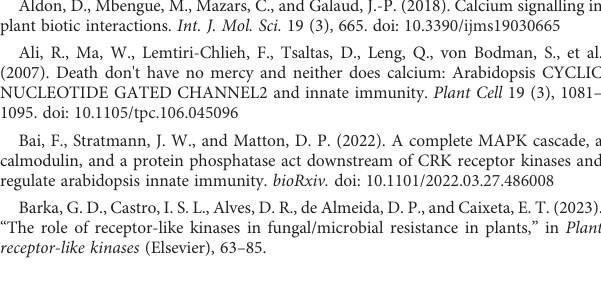
SUPPLEMENTARY FIGURE 1 Co-expression analysis of CDPK, CaMK, CBL, CML observed in Arabidopsis thaliana using STRING (version